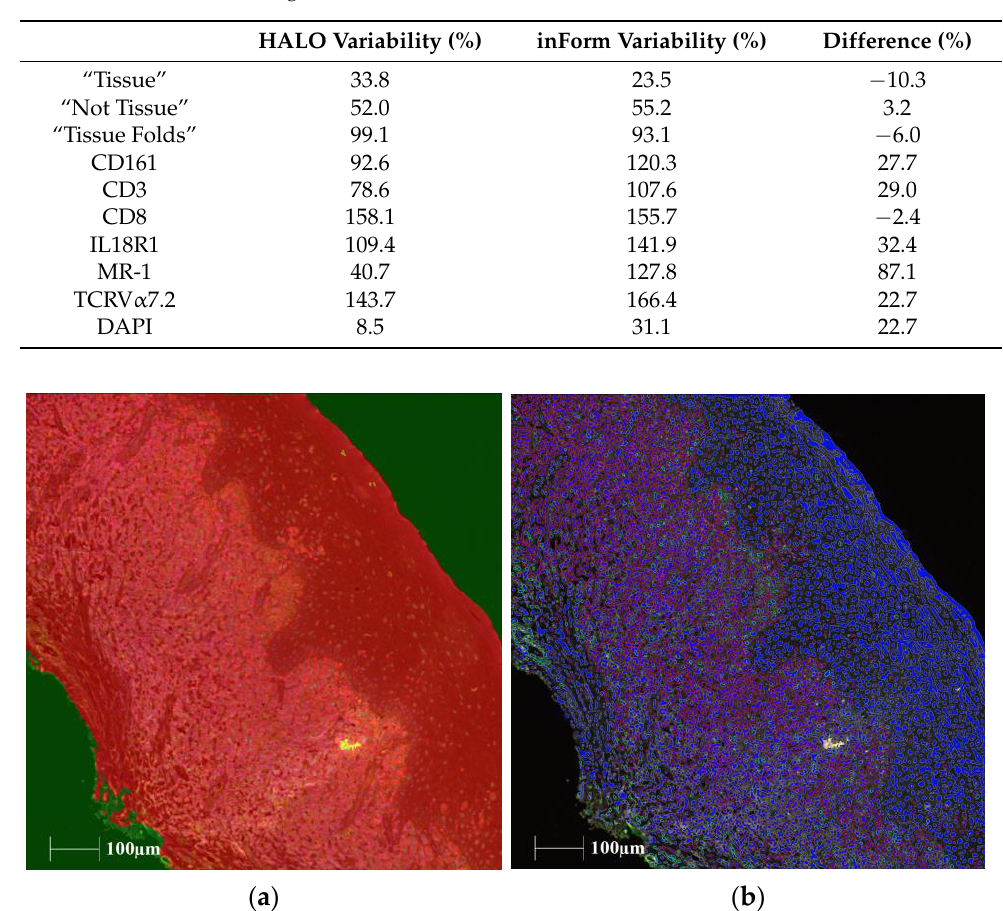
Figure 1. Representative images of trainable tissue segmentation and phenotyping performed with HALO™. ( a ) Tissue segmentation, ( b ) Phenotyping. Legend ( a ): red area = “tissue”, green area = “not tissue” , and yellow area = “tissue folds”. Legend ( b ): blue nucleus = DAPI positive, red membrane = CD3 positive, orange membrane = CD8 positive, cyan membrane = CD161 positive, yellow membrane = IL18R1 positive, magenta membrane = MR-1 positive, and green membrane = TCRVα7.2 positive.